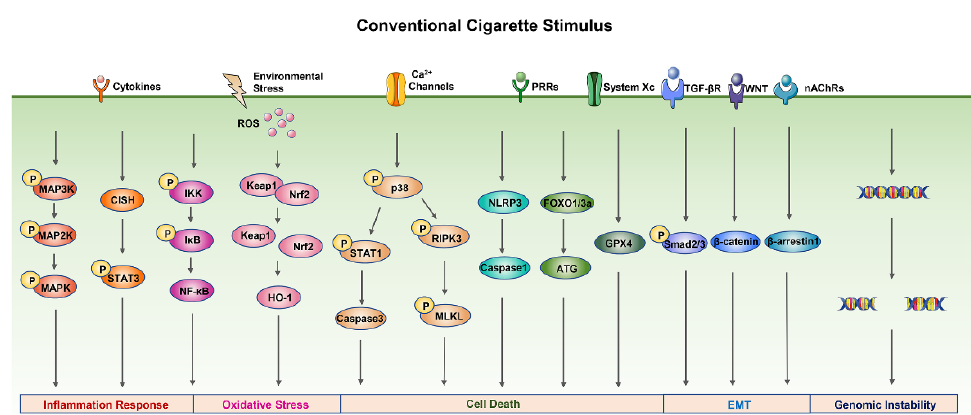
Figure 2. The main mechanisms of conventional cigarette smoke cytotoxicity. Cigarette smoke exposure can activate the MAPK, NF- κ B, and STAT3 signal pathways to promote the release of inflammatory mediators. ROS and other oxidants caused by cigarette smoke can stimulate Nrf2 and NF- κ B signal pathways to alter cellular redox homeostasis and lead to oxidative stress. Cell death caused by cigarette smoke exposure is related to the p38/STAT1/caspase-3 apoptosis signal pathway, p38/RIPK3/MLKL necroptosis signal pathway, NLRP3/caspase-1 pyroptosis signal pathway, GPX4 ferroptosis signal pathway, FOXO/ATG autophagy signal pathway, and so on. In addition, cigarette smoke exposure could promote ugh WNT/ β -catenin, TGF- β /Smad2/3, or nAChR-dependent signal pathways and cause DNA damage. Abbreviation: ATG, autophagy-related proteins; CISH, cytokine-inducible Src homology 2-containing protein; FOXO, forkhead box class O; GPX4, glutathione peroxidase 4; HO-1, heme oxygenase-1; I κ B, an inhibitor of NF- κ B; IKK, I κ B kinase; Keap1, Kelch-like ECH-associated protein 1; MAPK, mitogen-activated protein kinase; MLKL, mixed lineage kinase domain-like; nAChRs, nicotinic acetylcholine receptors; NF- κ B, nuclear factor κ B; NLRP3, nucleotide-binding domain-like receptor protein-3; Nrf2, nuclear factor erythroid-2-related factor-2; PRRs, pattern recognition receptors; RIPK3, receptor-interacting serine/threonine-protein kinase 3; ROS, reactive oxygen species; STAT, signal transduction and activator of transcription; TGF- β R, transforming growth factor- β receptors; WNT,